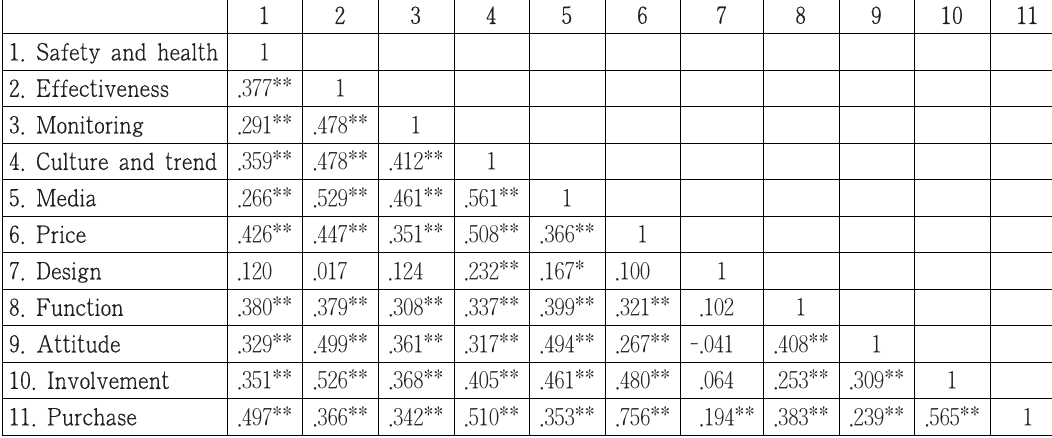
<Table 1> Correlation analysis of key